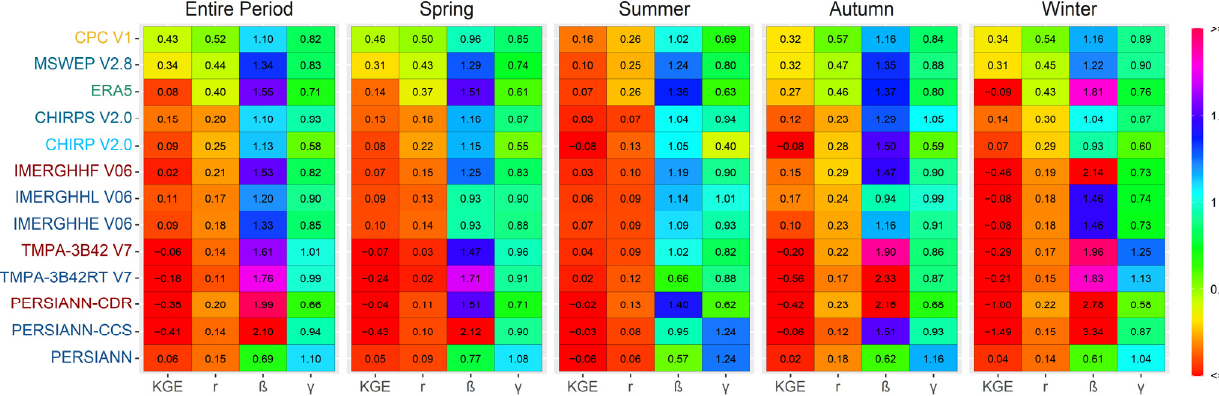
Figure 6. GPD reliability at regional scale under the Kling–Gupta efficiency (KGE) and its components for daily precipitation over the Karasu river basin for the entire period and four seasons. Y-axis color presents: satellite-based (blue), gauge and satellite (red), reanalysis and satellite (sky blue), reanalysis (green), reanalysis, ground, and satellite (steel blue), and ground (yellow).